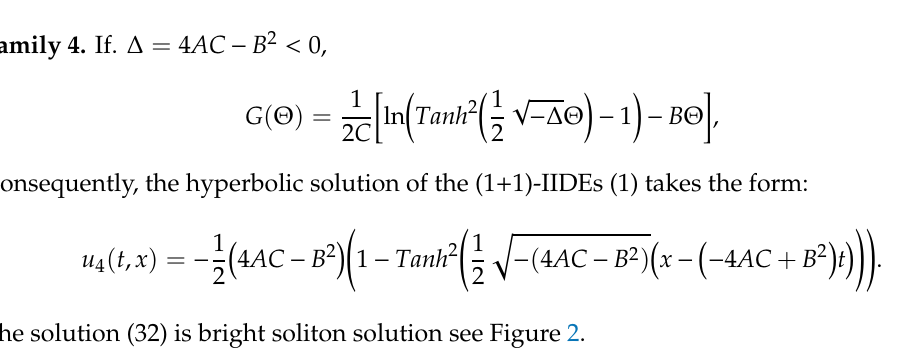
Figure 2. The bright soliton solution (32) of Equation (1) and its projection at 𝑡 = 0 when 𝐴 = 1, 𝐶 = 1, 𝐵 = 4.